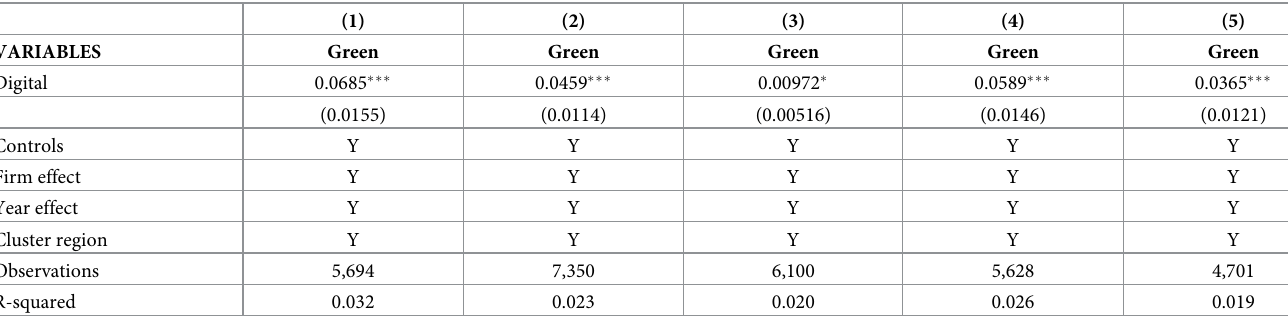
Table 5. Enterprise strategic behavior